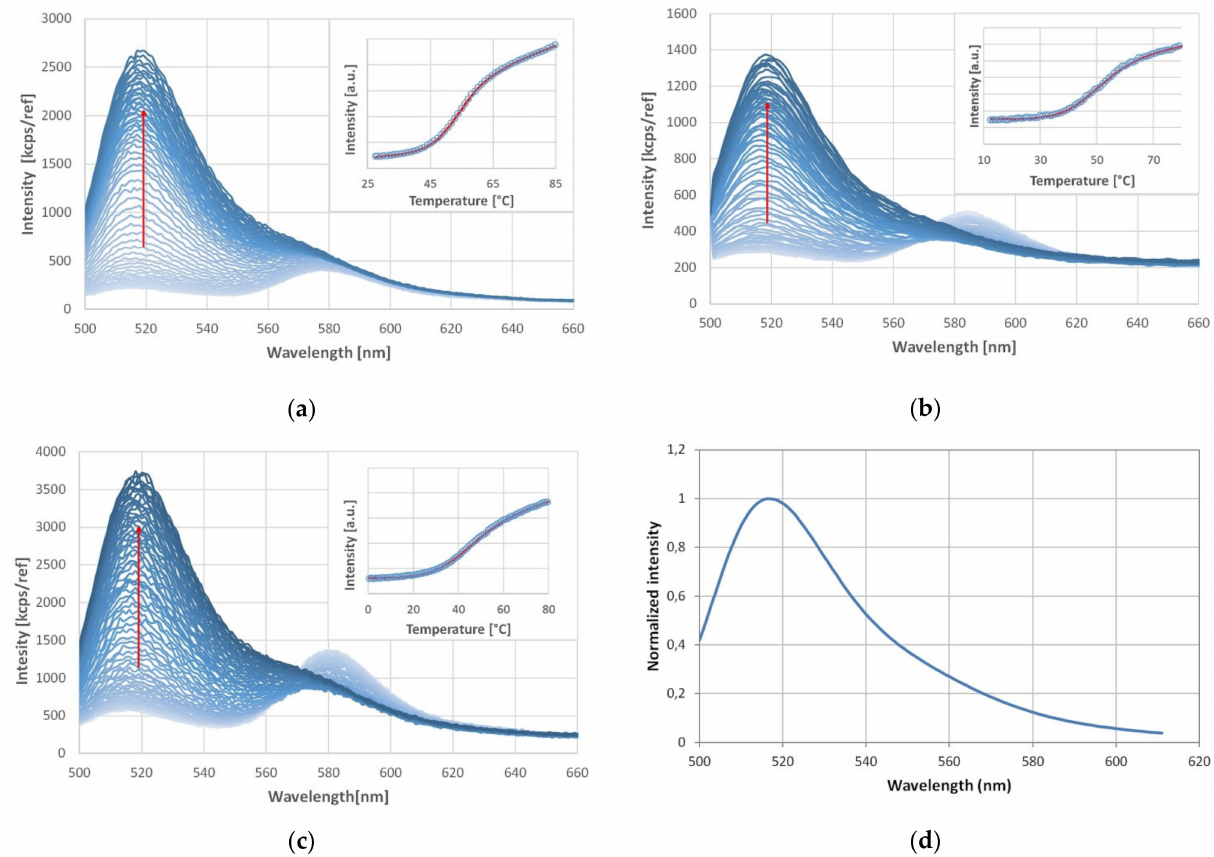
Figure 2. Fluorescence spectra of ( a ) HepB1, ( b ) HepB2, ( c ) HepB3 and ( d ) human telomere (Htel) at atmospheric pressure. The HepB oligos are labeled by the FRET pair FAM (as donor) and TAMRA (as acceptor), Htel was labeled only with FAM. The fluorescence intensity is divided with the signal of the reference diode of the spectrometer in order to standardize the experiments. The lowest temperature spectrum has the lightest color while the high temperature one is dark. Additionally a red arrow shows the direction of the spectral changes during temperature increase. The inserts in ( a – c ) show the fit of the donor intensity with the function of Equation (1). The oligos were measured in presence of 140 mM K-phosphate buffer (pH 7.4). The oligo labeled with FAM only can be seen in panel ( d ) to show the case, when there is no energy